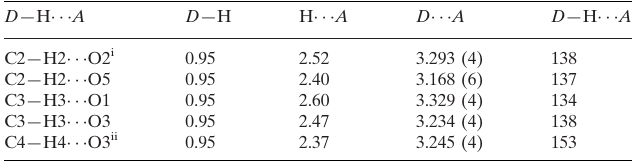
Hydrogen-bond geometry (A˚ , (cid:5)